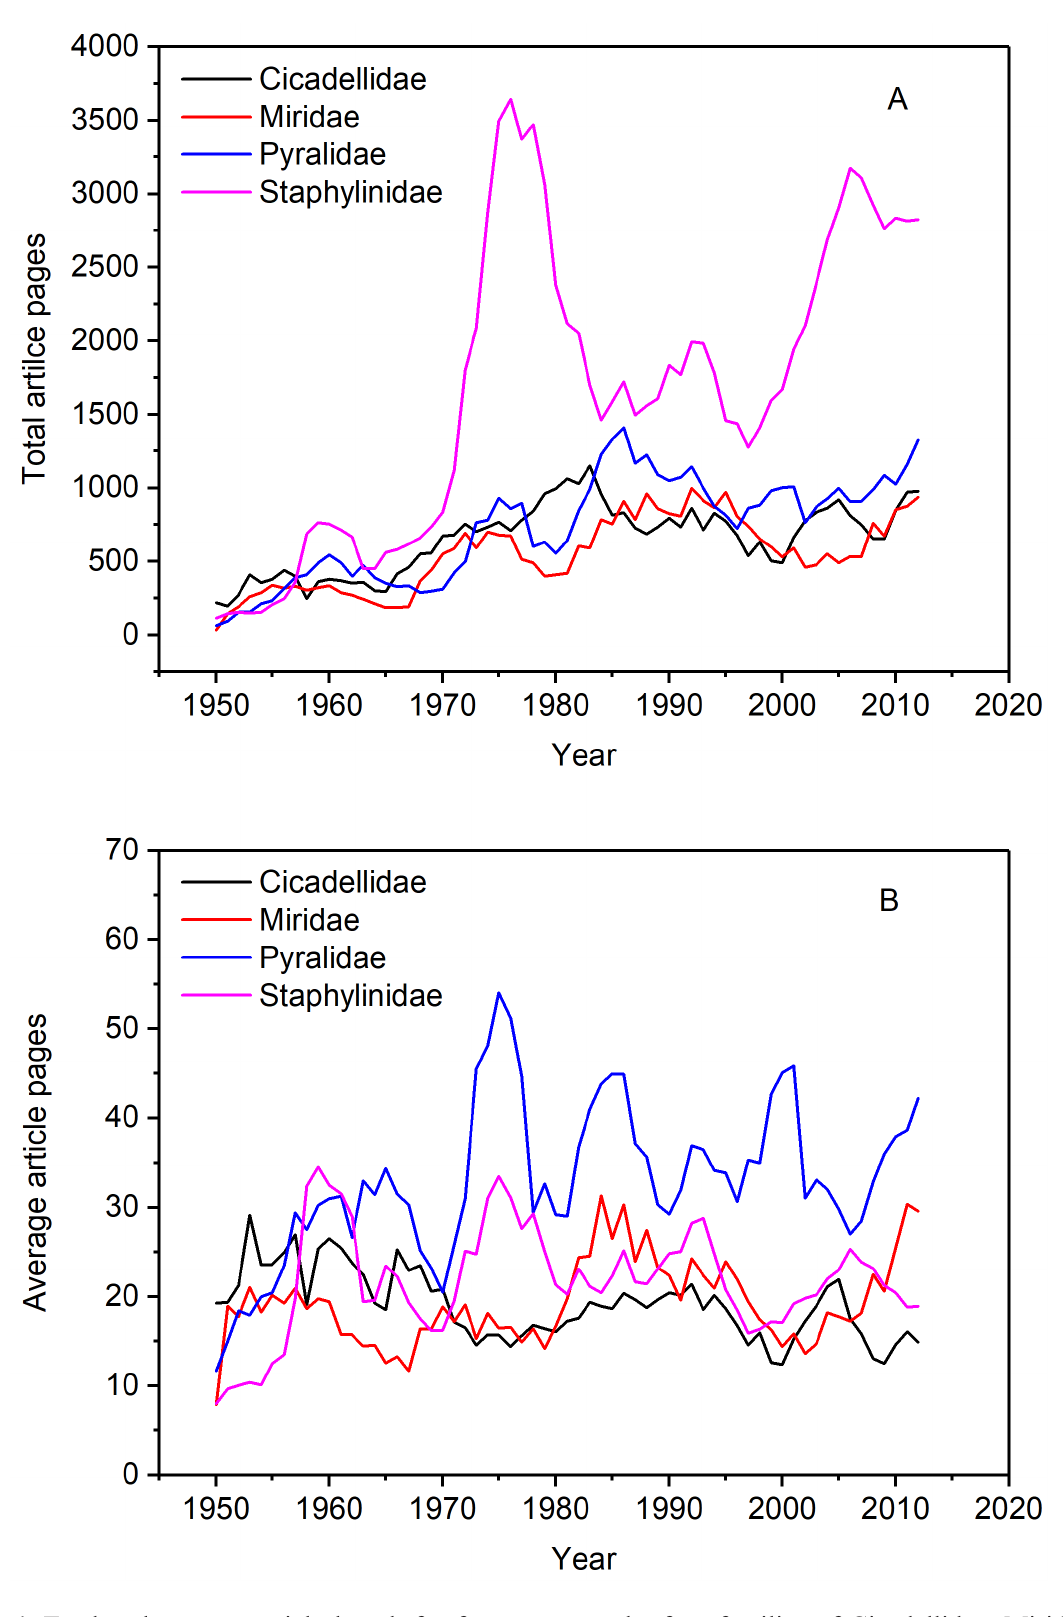
Fig 4. Total and average article length for for papers on the four families of Cicadellidae, Miridae, Pyralidae and Staphylinidae between 1946 and